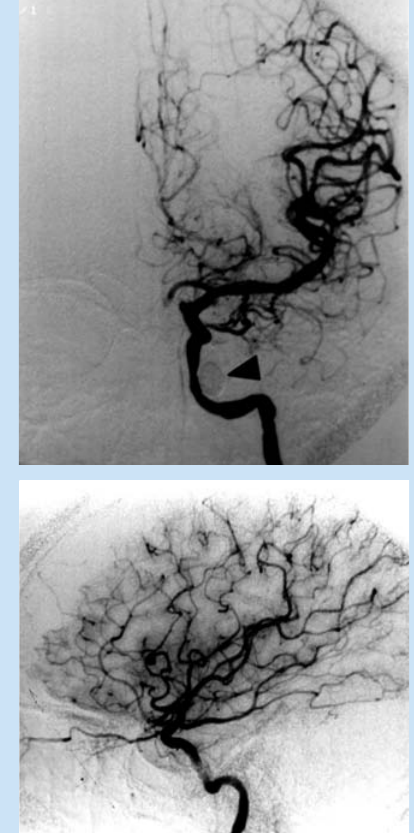
Fig. 1c and 1d. Frontal and lateral internal carotid angiograms following embolisation with one bal- loon (arrow) and preservation of the carotid